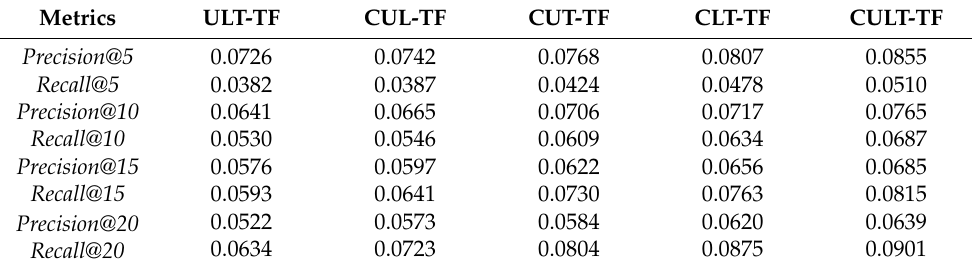
Table 6. Precision and recall of different baseline